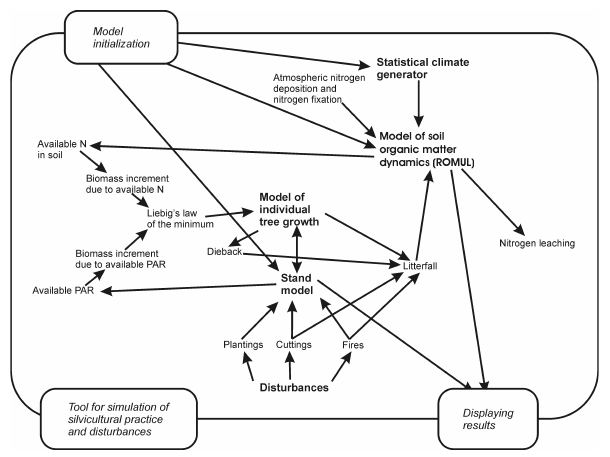
Fig. 1. The flowchart of the EFIMOD model. From Shanin et al. (2012), as subsequently